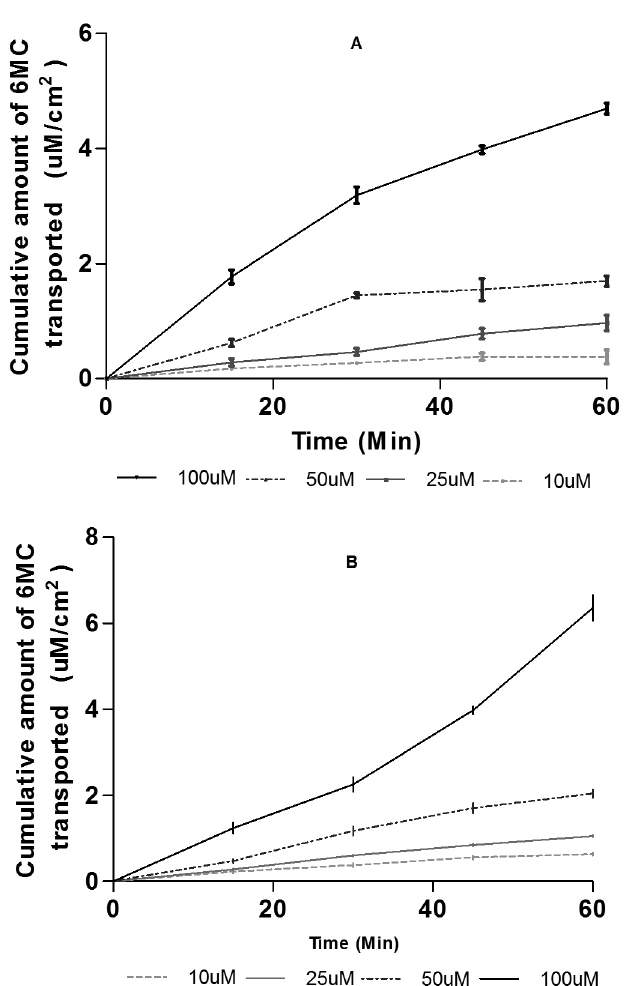
FIGURE 2 - Transport of 6-methylcoumarin across Caco-2 cells. Cumulative amount of 6-methylcoumarin transported across Caco-2 cells in the Apical to Basolateral (A) or Basolateral to Apical direction (B). Data are expressed as means ± SD of six independent monolayers. TABLE II - Plasma pharmacokinetics parameters of 6-methylcoumarin after oral and intraperitoneal administration in Wistar rats,